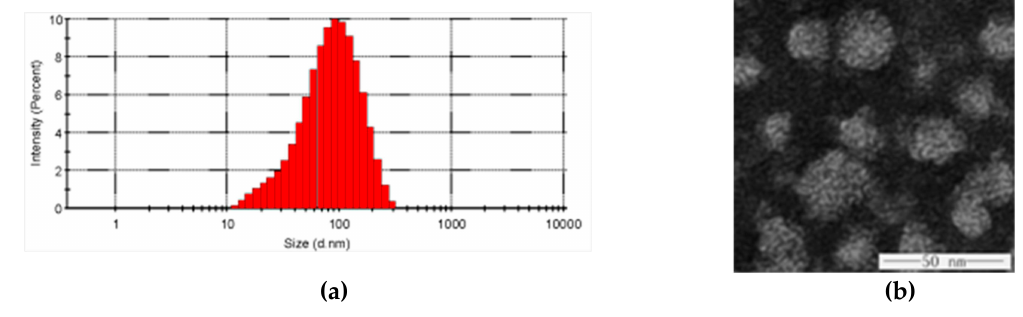
Figure 2. Size distribution profiles for mPEG-PCL-Ace-PTX 5 micelles determined by dynamic light scattering (DLS) ( a ) and transmission electron microscopy (TEM) ( b ).